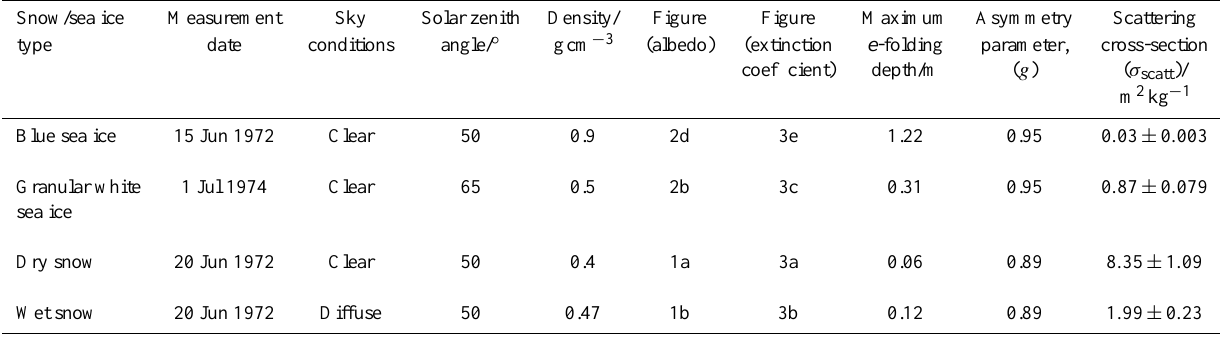
at a 1 km altitude, with an optical depth of 32, an asym- metry parameter of 0.85 and a single-scattering albedo of 0.9999. Diffuse sky conditions were used to calculate sur- face albedo independent of solar zenith angle. The albedo of sea ice and snow depend on the solar zenith angle but are not dependant on the absolute irradiance of incident